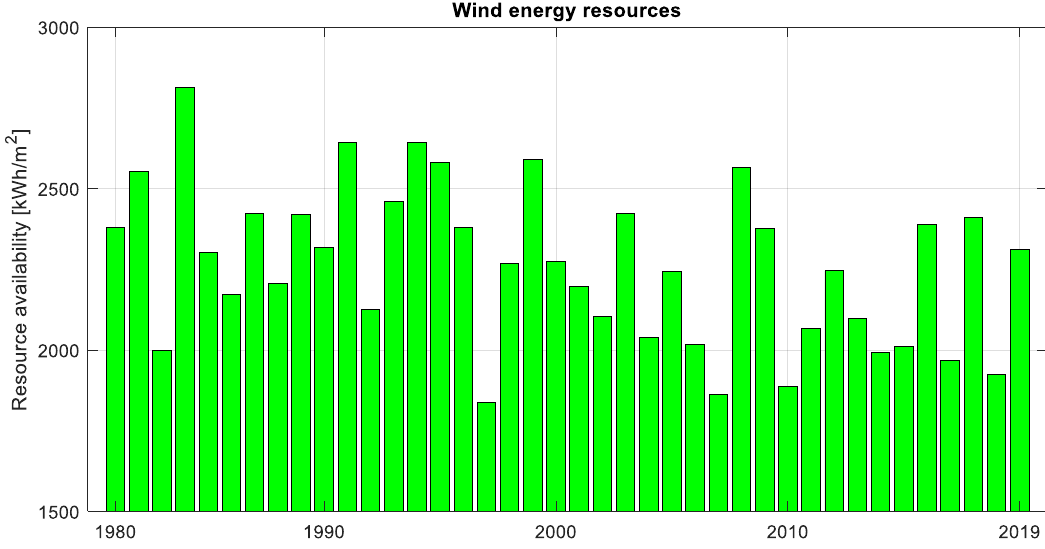
Figure 4. Multi-annual (1980–2019) change in country-wide mean annual sum of irradiation on horizontal surface. Calculations considered only ERA5 grid points within Polish borders.